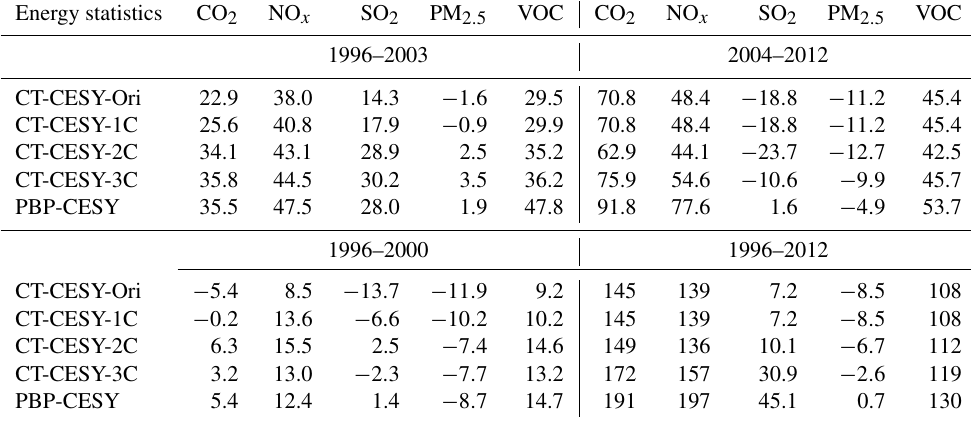
Table 3. Emission trends for China derived from different energy statistics (growth rate, %). Energy statistics CO 2 NO x SO 2 PM 2 .